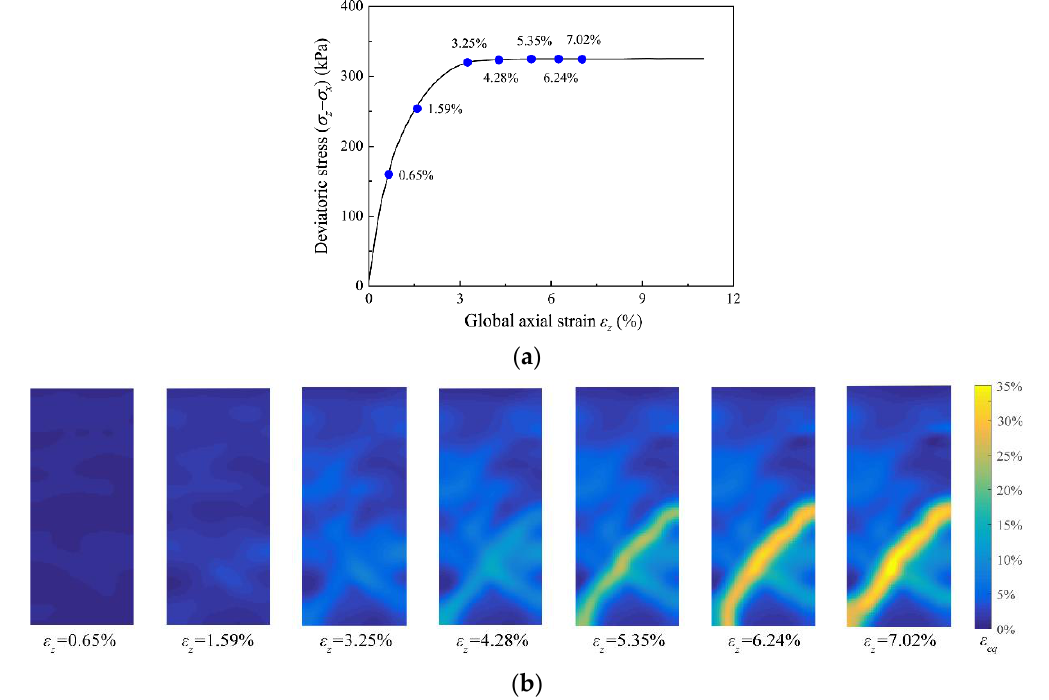
Figure 9. Results of DIC analyses for the T5 test: ( a ) global stress – strain relationship for the T5 test; ( b ) shear strain distribution at different stages in the T5 test.